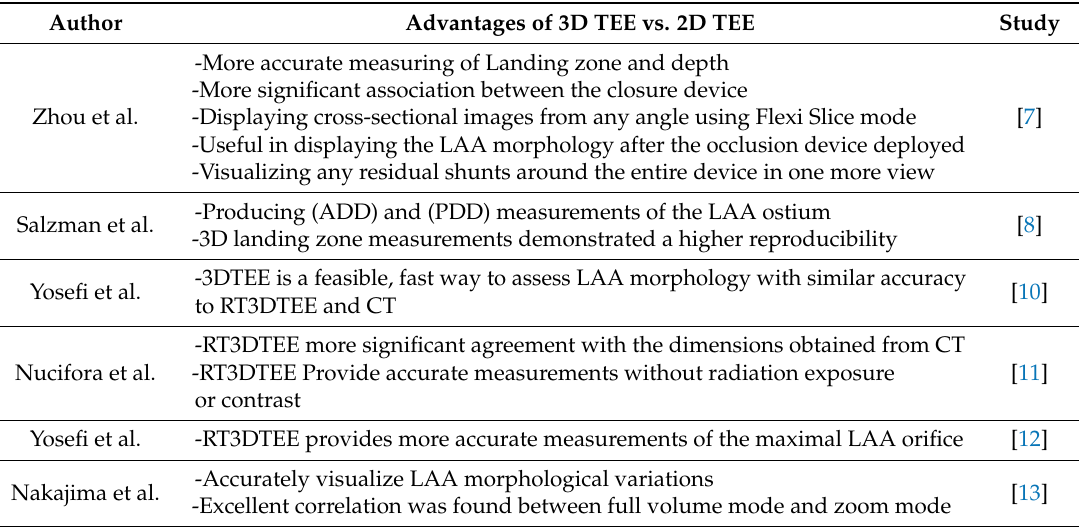
Table 1. Advantages of 3D TEE vs. 2D